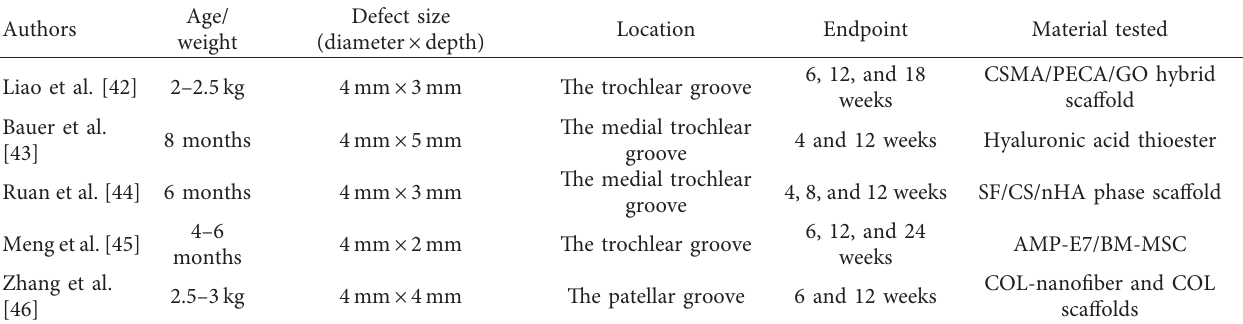
Table 3: Examples of studies using rabbit osteochondral defect